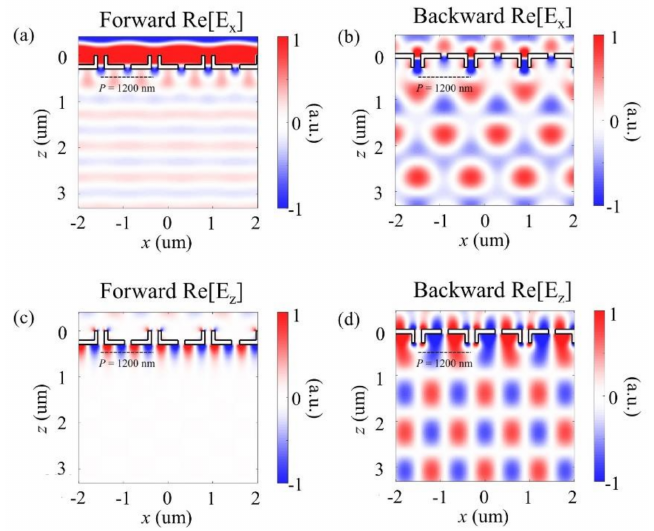
Figure 3. Real part of the E x field distribution for ( a ) forward (Forward Re[ E x ]) and ( b ) backward illumination cases (Backward Re[ E x ]). The simulated real part of the E z propagate ( c ) without diffraction (Forward Re[ E z ]) and ( d ) with diffraction (Backward Re[ E z ]) illumination on the proposed